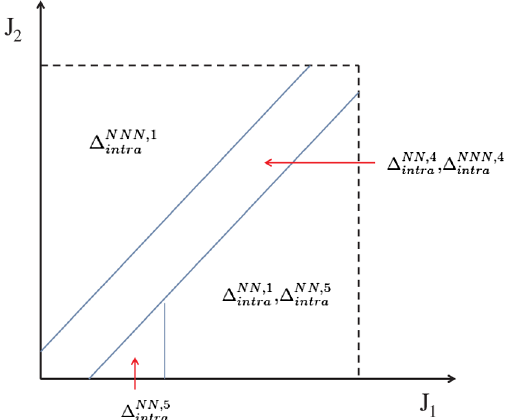
FIG. 5. Schematic phase diagram for the model (4) within ; J < 1 . 0 < J 2 2